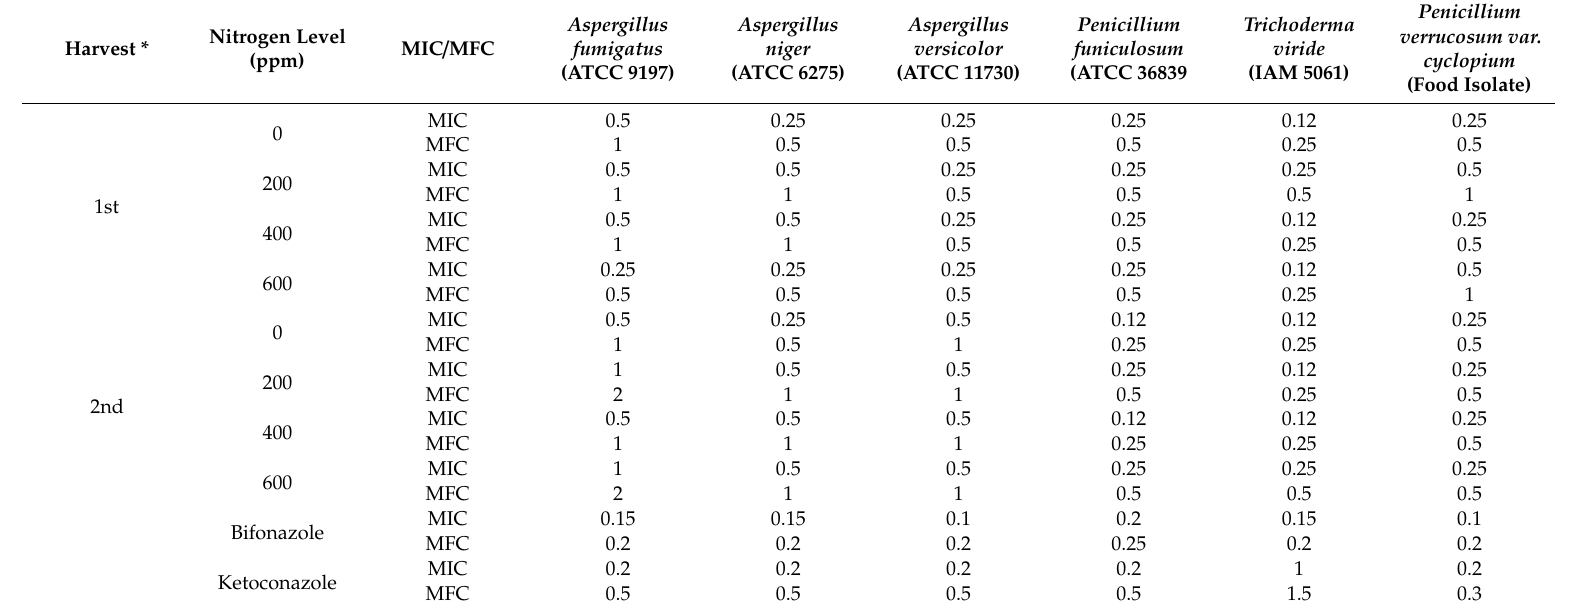
Table 12. Antifungal activity Centaurea raphanina (MIC and MFC mg / mL) of Centaurea raphanina subsp. mixta plants grown in 2 L pots under greenhouse conditions, in relation to harvesting time (1st and 2nd harvest) and nitrogen level (0–600 ppm) (mean ± SD; n =